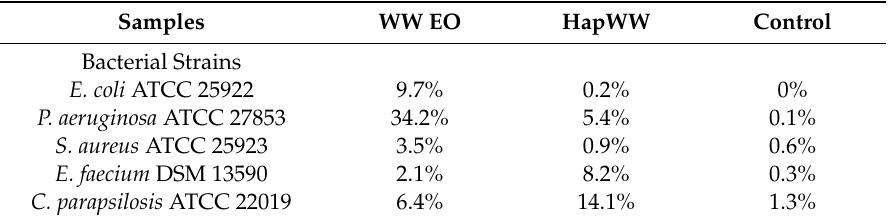
Table 5. The percentage of depolarized bacterial cells treated with WWEO and HApWW at MIC values. Samples WW EO